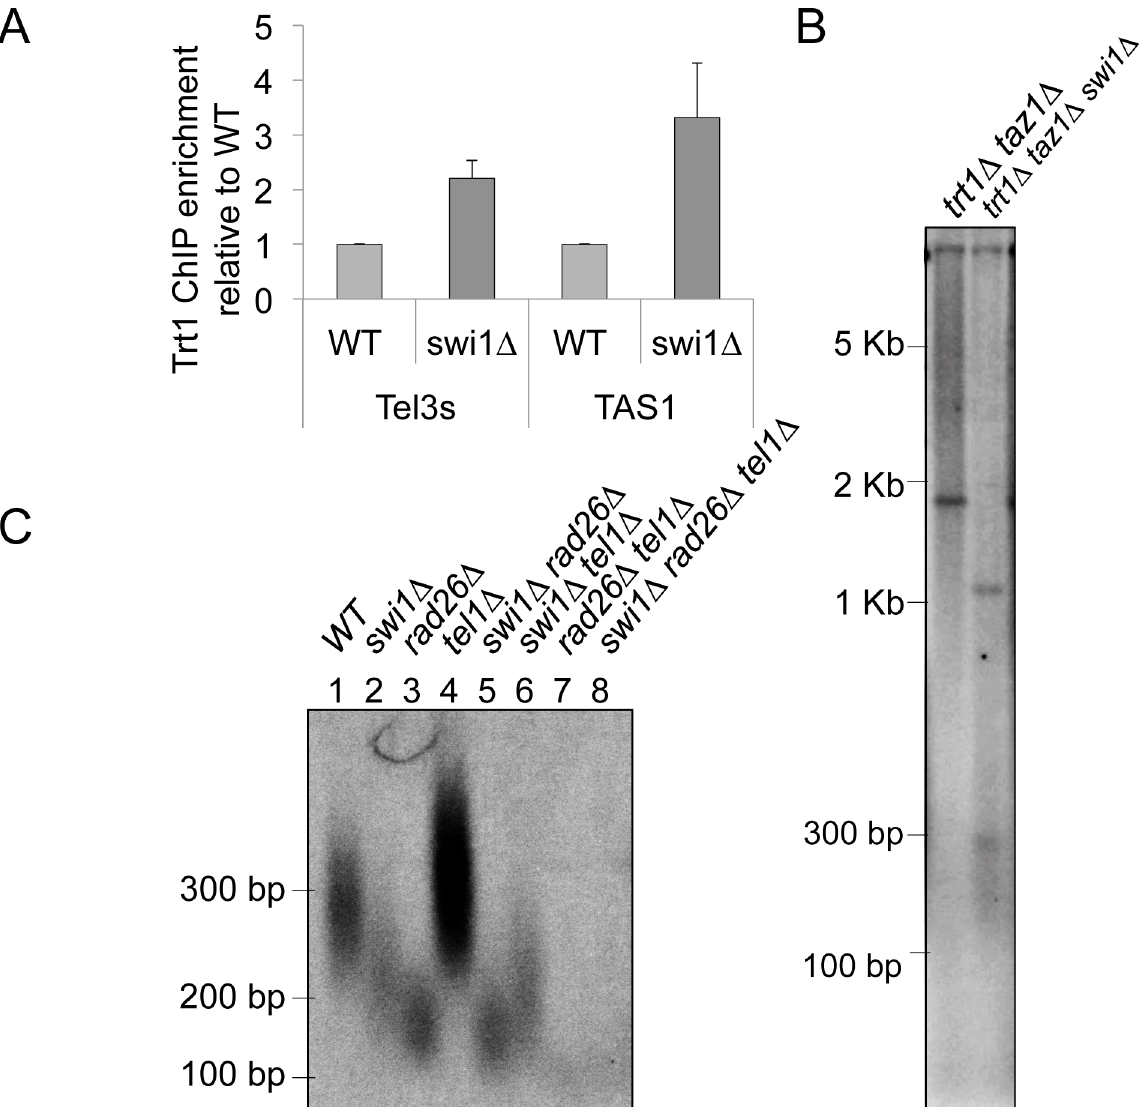
Fig 6. Telomere shortening in swi1 Δ mutants is not caused by defects in telomerase recruitment at telomeres. (A) Strains of the indicated genotypes were engineered to express Trt1-G9-5FLAG [50]. ChIP results show that telomerase is preferentially recruited at short telomeres in swi1 Δ mutants compared to wild-type length telomeres. Telomerase recruitment was monitored by competitive multiplex PCR at two different subtelomeric regions: Tel3s and TAS1. GFR1 (for Tel3s) and GFR2 (for TAS1) were amplified as internal control regions in multiplex PCR reactions. Trt1 enrichment at Tel3s and TAS1 over control regions was determined. Data is shown as relative fold enrichment in comparison to WT. Error bars represent the standard deviation obtained from three independent experiments. (B) trt1 Δ taz1 Δ and trt1 Δ taz1 Δ swi1 Δ cells were passaged at least 8 times, and Southern blot analysis of Apa I-digested genomic DNA was performed as described in Fig 2B. (C) Genetic interaction between Swi1 and Rad3-Rad26 in telomere maintenance. Genomic DNA was isolated form the indicated cells, and telomere southern analysis was performed as described in Fig 2B.